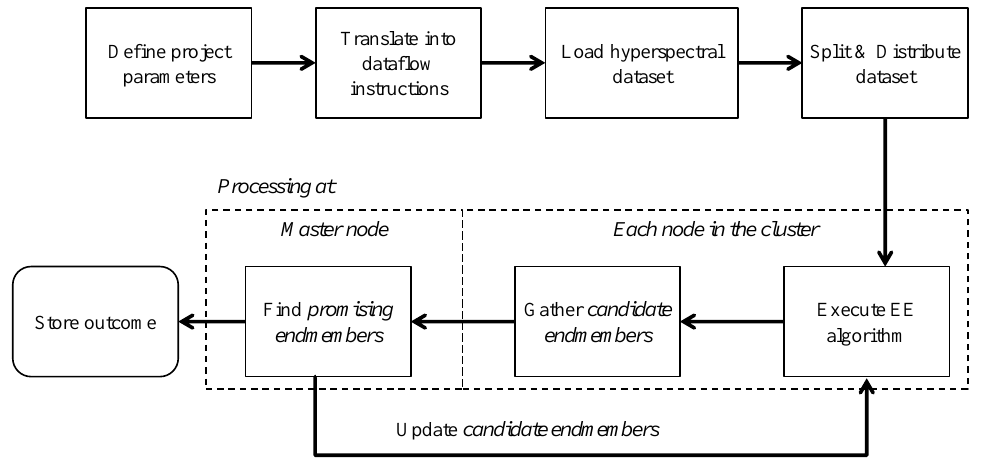
Figure 2. General outline of the HyperCloud-RS distributed processing